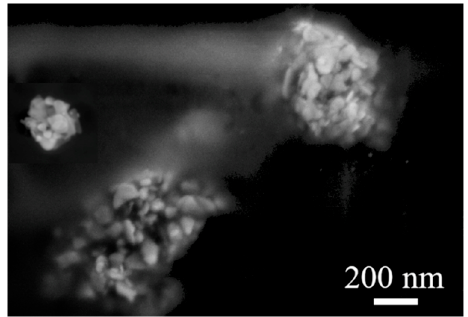
Figure 7. SEM microphotograph of AgNPs clusters in the PVA–AgNPs thin film, sample B.